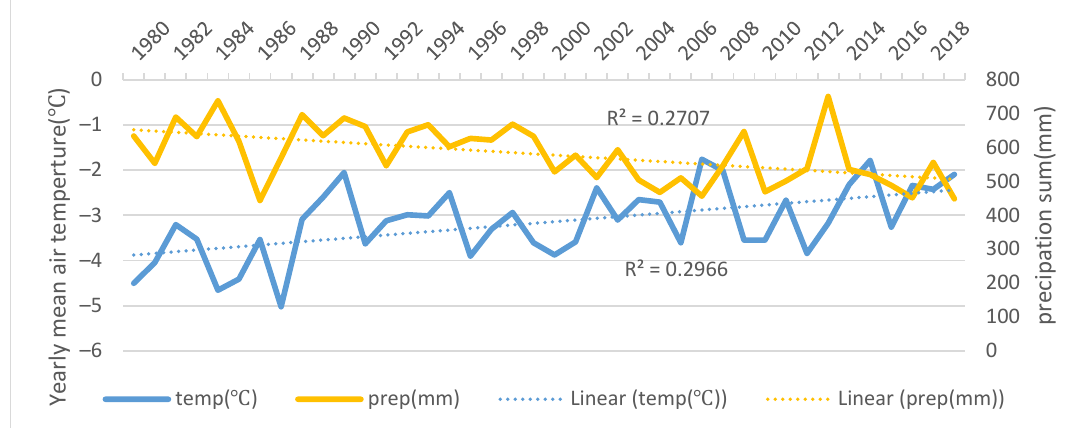
Figure 5. Regional yearly air temperature and precipitation change.